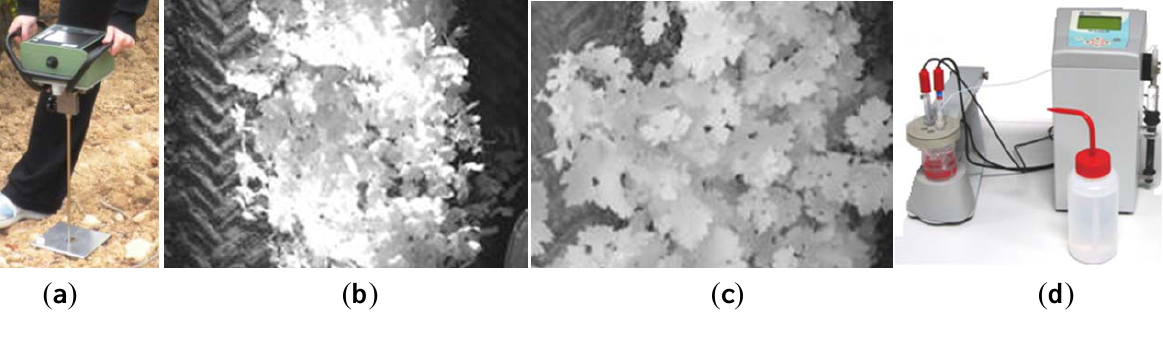
Figure 4. CB map of average soil resistance